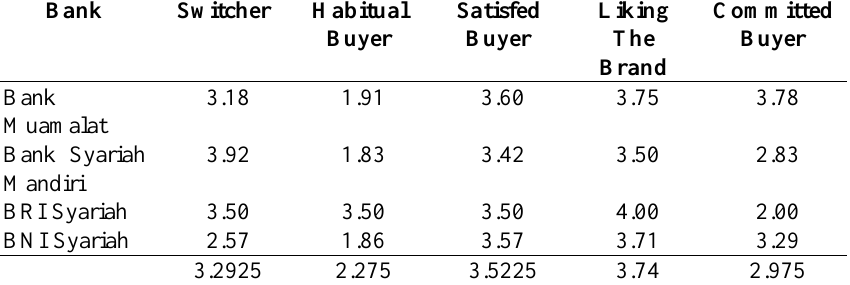
Table 2 Comparison of Average Values of Loyalty Levels of Islamic Banks Bank Switcher Habitual